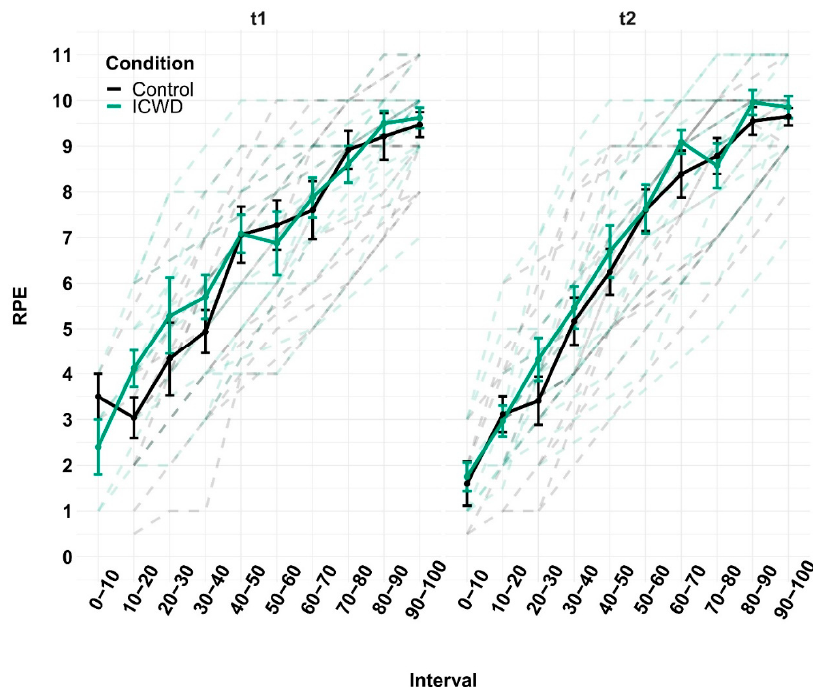
Figure 4. Rate of perceived effort. Mean rate of perceived exertion (RPE) are displayed throughout the time normalized task (Interval) during the first (t1) and second (t2) experimental session for the control (black) and ICWD (green) groups. The dashed lines correspond to individual data. Error bars correspond to SEM. Table 2. Neuromuscular results. Mean ± SD of maximal voluntary contraction (MVC) in N), voluntary activation (VA in %) and potentiated twitch at rest (Ptw in N) of both groups (Control vs. ICWD) at T1 and T2 sessions and pre- and post-knee extension task.